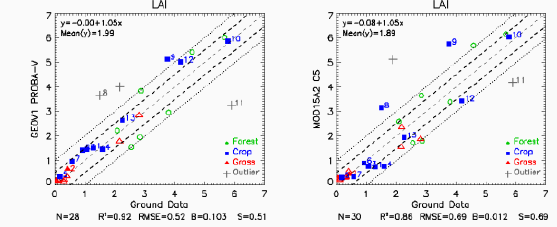
Figure 12: Comparison of satellite LAI product with the ground-based maps. Left side: PROBA-V GEOV1. Right side: MODIS C5. Filled symbols correspond to concomitant values of 2014 from ImagineS and unfilled symbols to a different year.